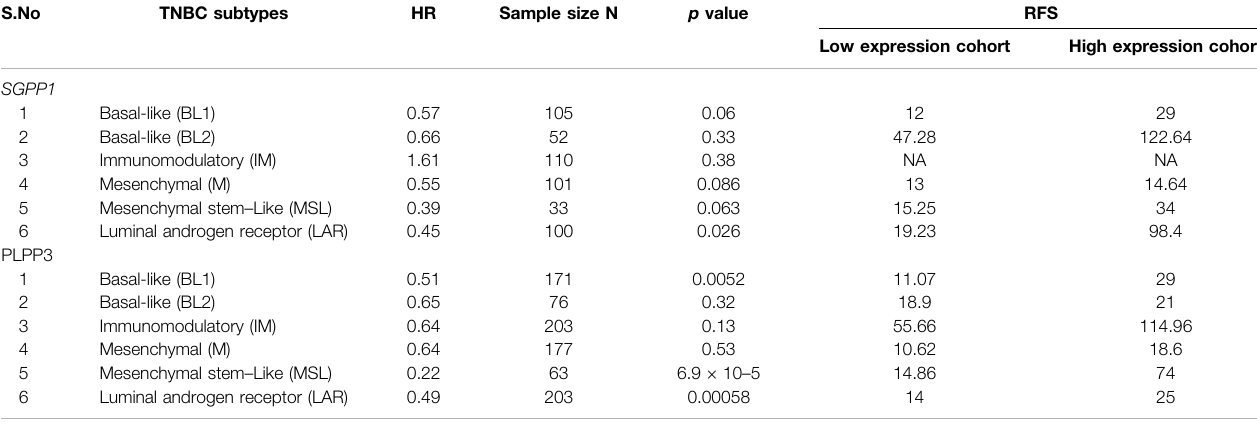
TABLE 2 | Correlation between mRNA expression of SGPP1 and PLPP3 with relapse-free survival (RFS) in Pietenpol subtypes of triple-negative breast cancer (TNBC). S.No